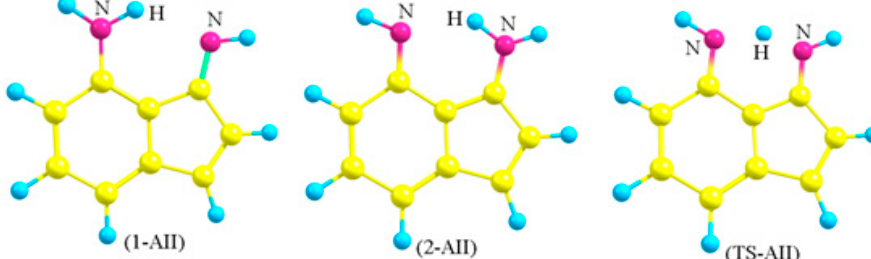
Figure 3. The numbering system of the two tautomers (1-AII and 2-AII) and the transition state (TS-AII) of (4-Amino-3-imino)indene. The other hydrogen atoms are omitted for simplicity.